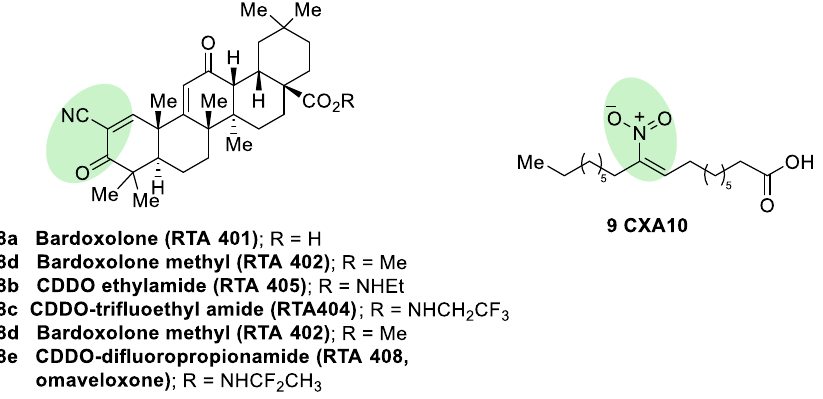
Figure 8. Chemical structures of some semisynthetic cyanoenone triterpenoids ( 8 ) and a nitro fatty acid ( 9 ). These compounds are considered electrophilic NRF2 inducers due to the presence of α , β -unsaturations conjugated with carbonyl, cyano, or nitro groups. These electrophilic moieties are highlighted in green.